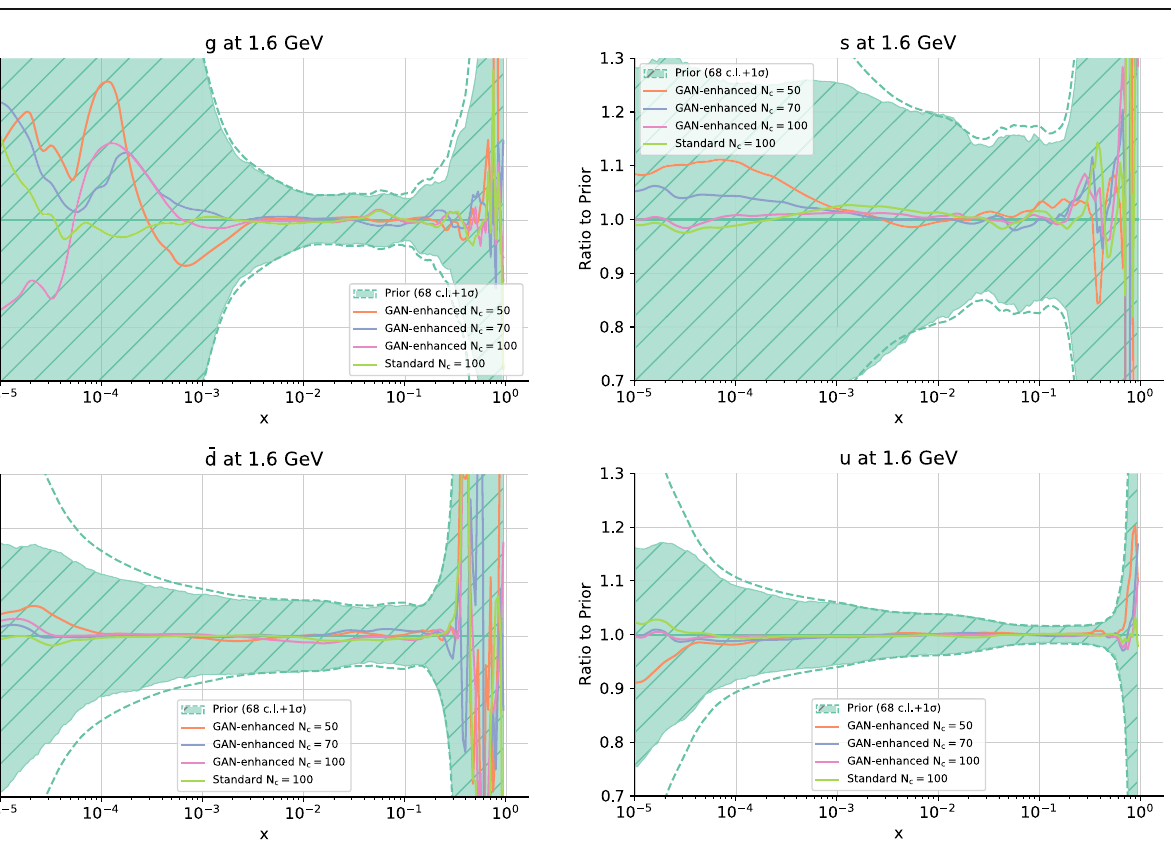
band while the 1-sigma is given by the dashed green curves. As a ref- erence, results from the standard compression for N c = 100 are also